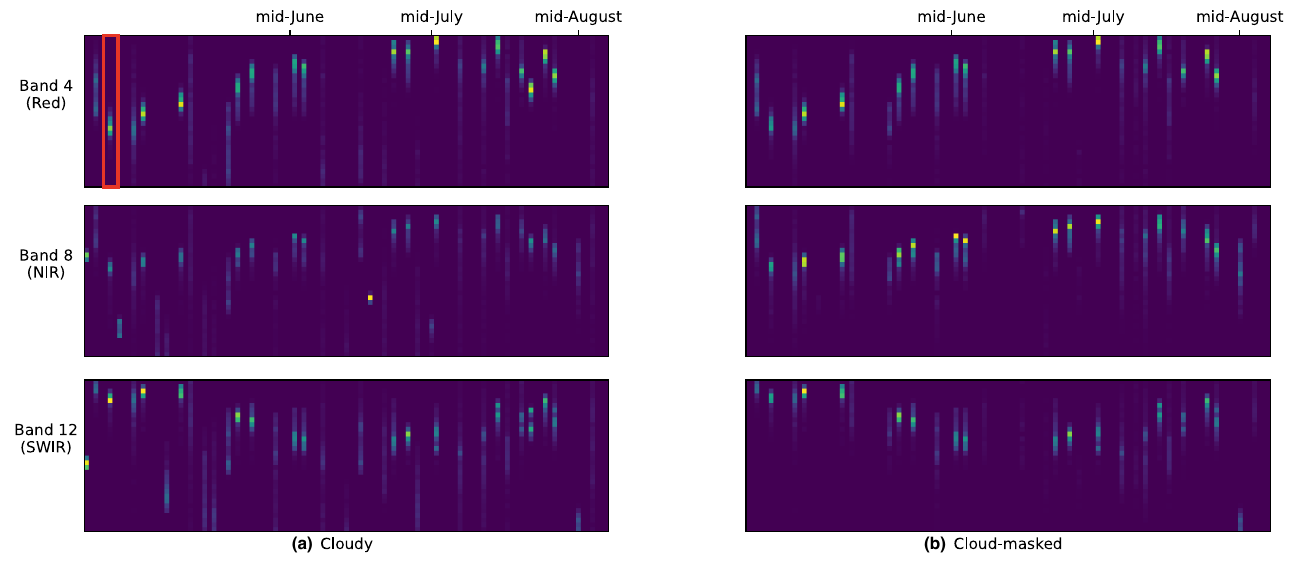
Figure 6. Histograms of three Sentinel-2 bands from spring wheat fields of a farm calculated from ( a ) cloudy and ( b ) cloud-masked surface reflectance. The x-axis is time, and the y-axis is the reflectance value range of the histograms (low values at the bottom, high values at the top). The red rectangle is an example of one timepoint in the early May, when the observed pixel values from spring wheat fields of a farm are shrunk into a 32-bin histogram. The brightest yellowish bins are the value ranges where the pixel counts are the